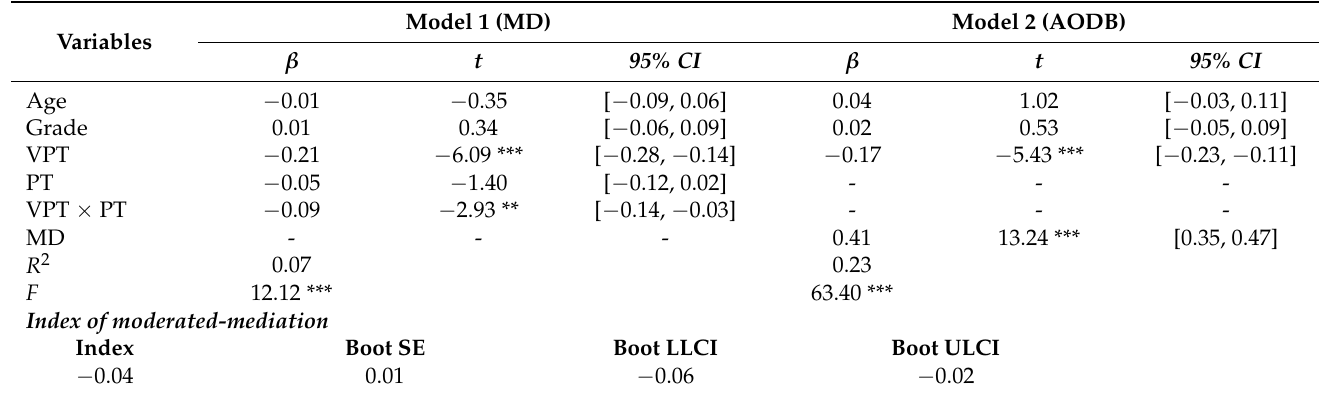
Table 3. Testing the moderated mediation model.